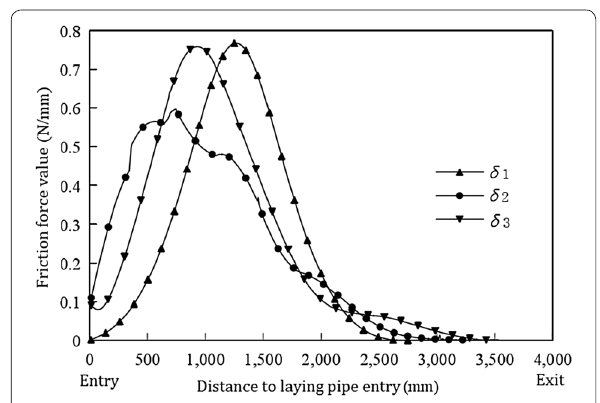
Figure 18 Friction force for three laying pipes